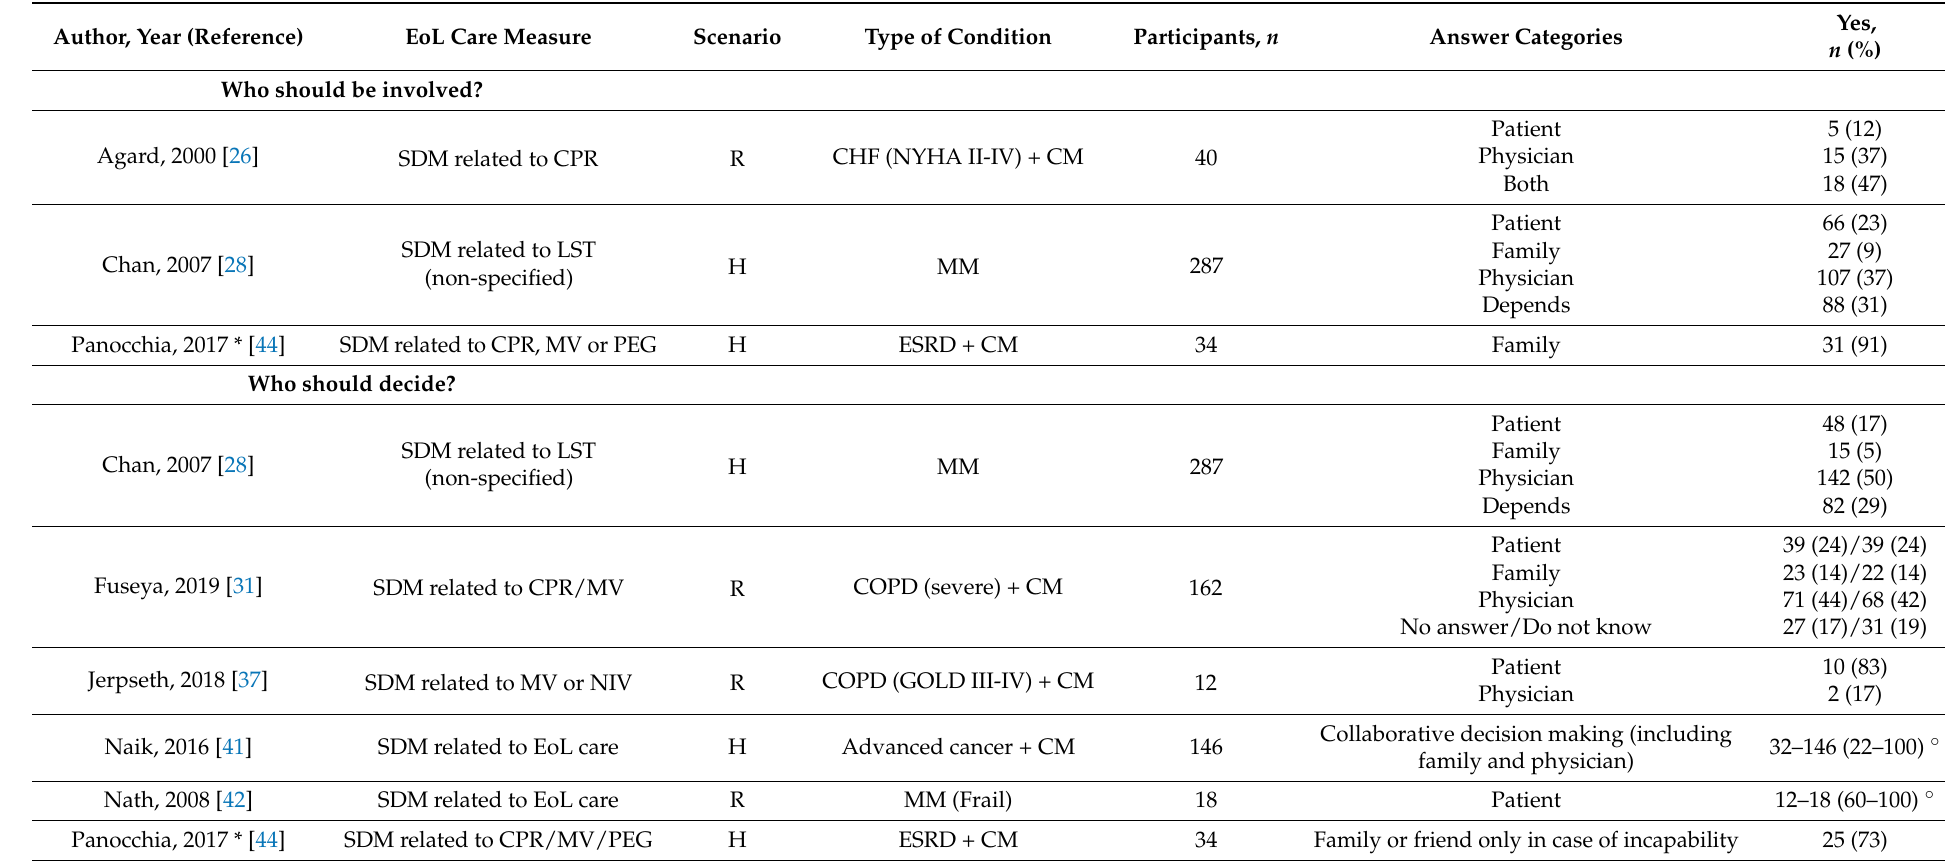
Table 5. Preference for